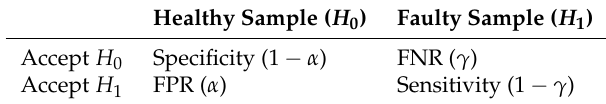
Table 6. Relationship between specificity and sensitivity, false-positive rate (FPR) and false-negative rate (FNR).